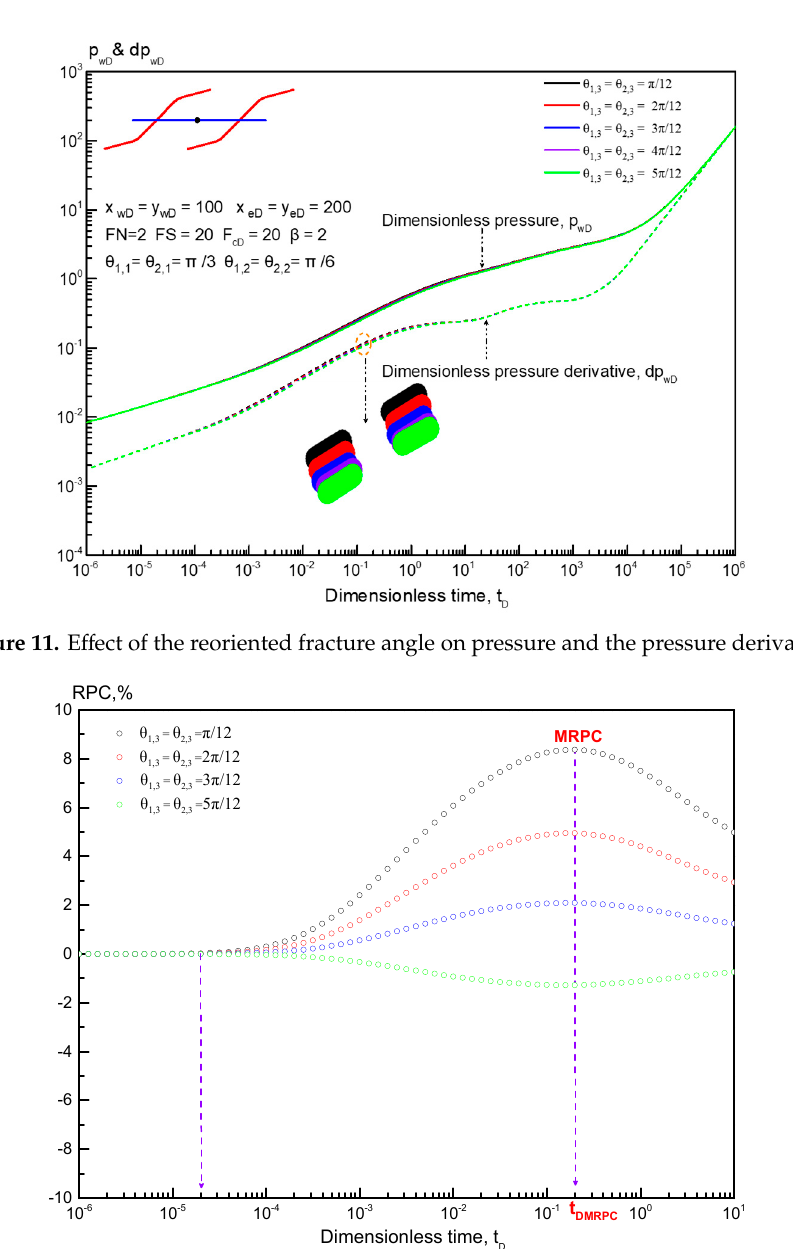
Figure 12. Reoriented fracture angle on relative pressure change.